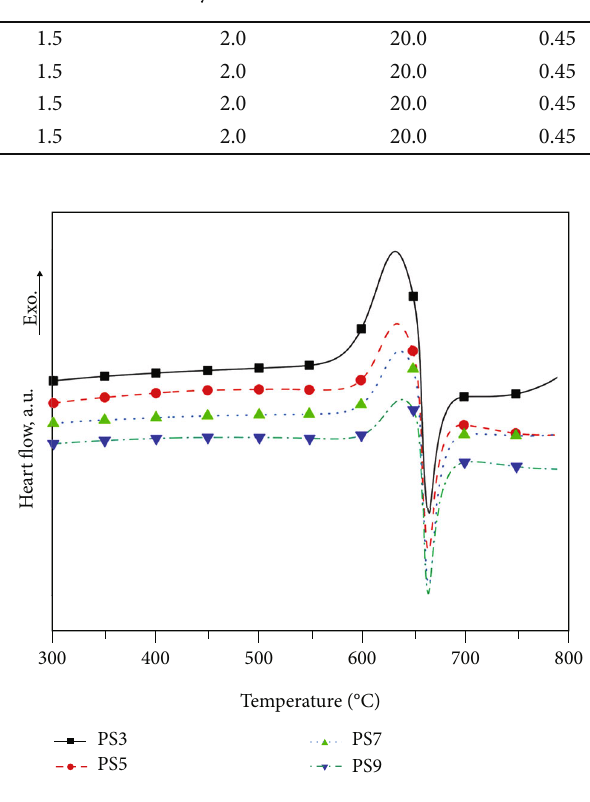
Figure 4: The DSC curve of di ff erent Al powder.